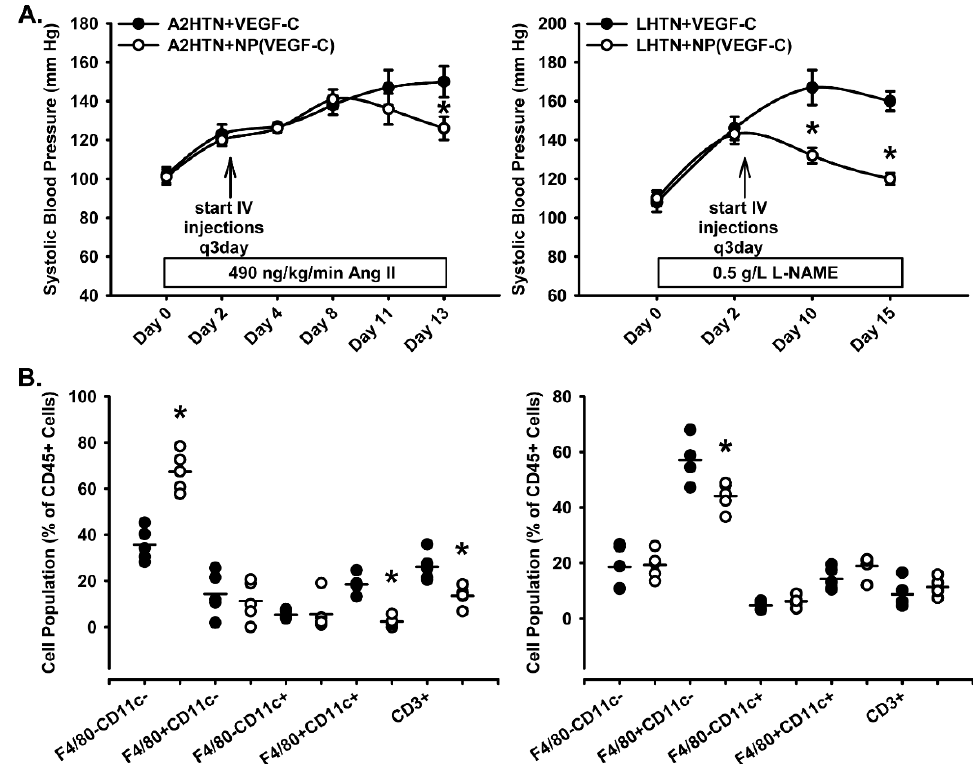
Figure 3. Following treatment with VEGF-C in NPs, significantly decreased blood pressure, and favorably altered renal immune cells, were observed. ( A ) Systolic blood pressure measures in male and female A2HTN and LHTN mice treated every 3 days with VEGF-C in NPs or VEGF-C alone. ( B ) Immune cell populations expressed as a percentage of CD45+ cells in kidneys of male and female A2HTN and LHTN mice treated every 3 days with VEGF-C in NPs or VEGF-C alone as determined by flow cytometry. Results are expressed as mean ± SEM or mean (n = 4–5 per group) and statistical analyses were performed with Student’s t -test or one-way ANOVA. * p < 0.05 vs. VEGF-C-alone treated mice.